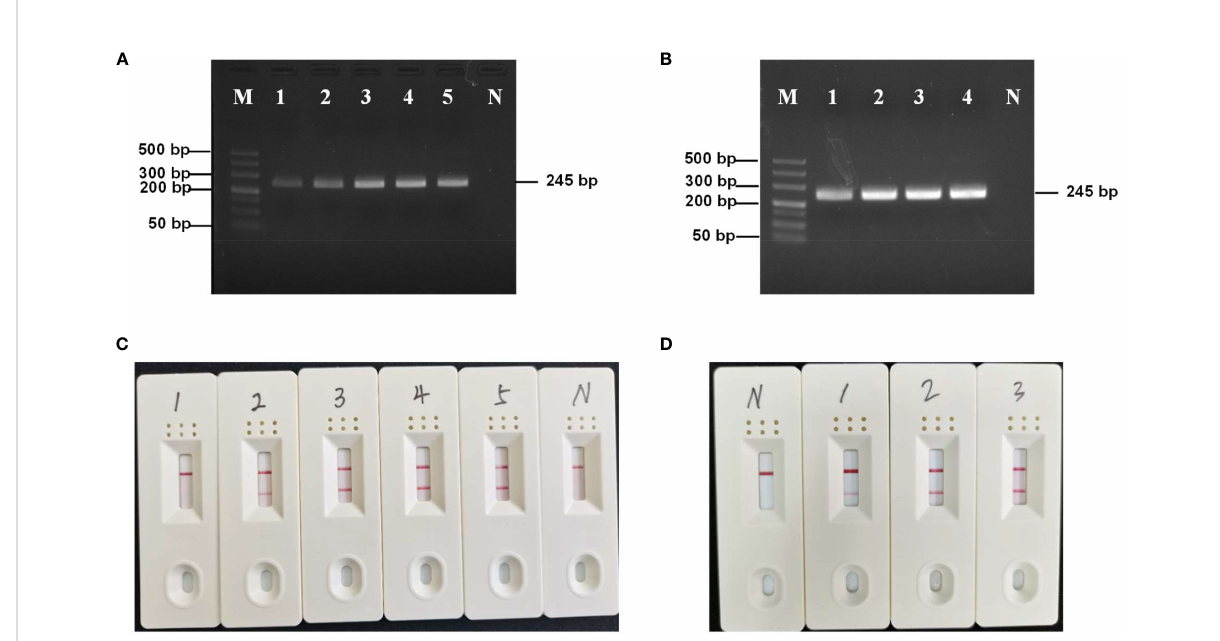
FIGURE 1 (A) Optimizing the RPA-AGE reaction temperature. M: DL 500 Marker; N: negative control; lines 1 – 5: 25°C, 30°C, 37°C, 39°C, and 42°C, respectively. (B) Optimizing the RPA-AGE reaction time. M: DL 500 Marker; N: negative control; 1: 10 min; 2: 20 min; 3: 30 min; 4: 40 min. (C) Optimizing the RPA-LFD reaction temperature. N: negative control; 1: 25°C; 2: 30°C; 3: 37°C; 4: 39°C; 5: 42°C. (D) Optimizing the RPA-LFD reaction time. N: negative control; 1: 5 min; 2: 10 min; 3: 20 min.